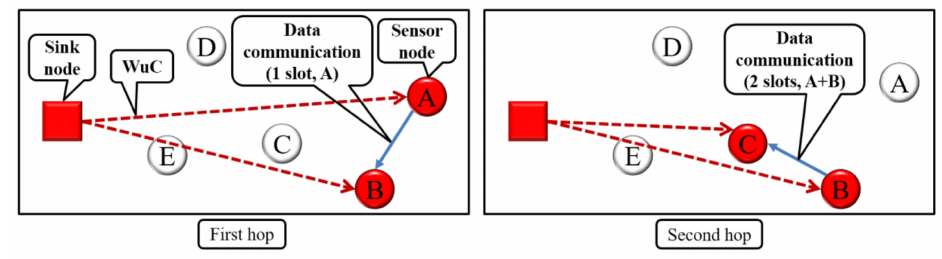
Figure 4. Data collection procedure in the proposed